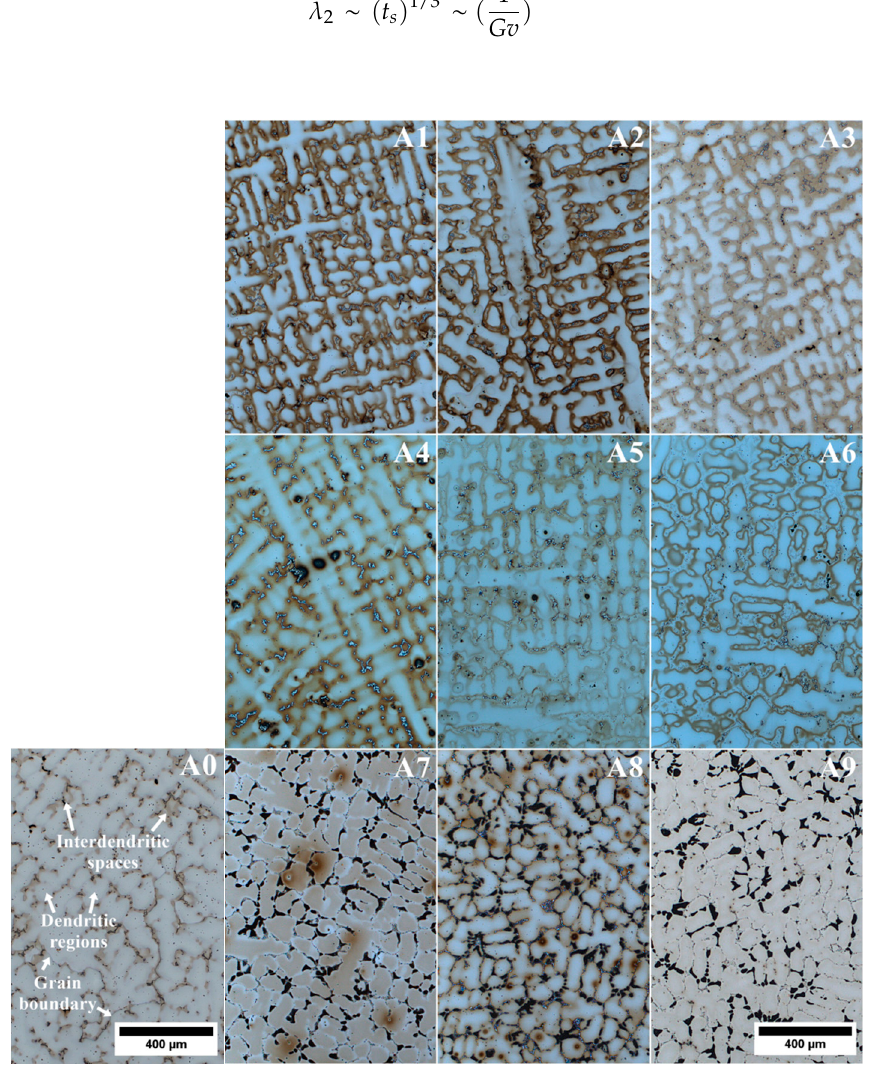
Figure 4. Primary microstructure of remelted Inconel 740 (A0) and modified A1–A9 variants.